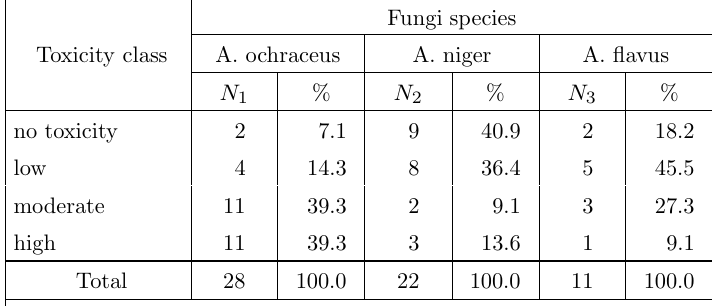
Table 2. Frequencies of the toxicity classes in all three fungi under study Fungi species Toxicity class A.